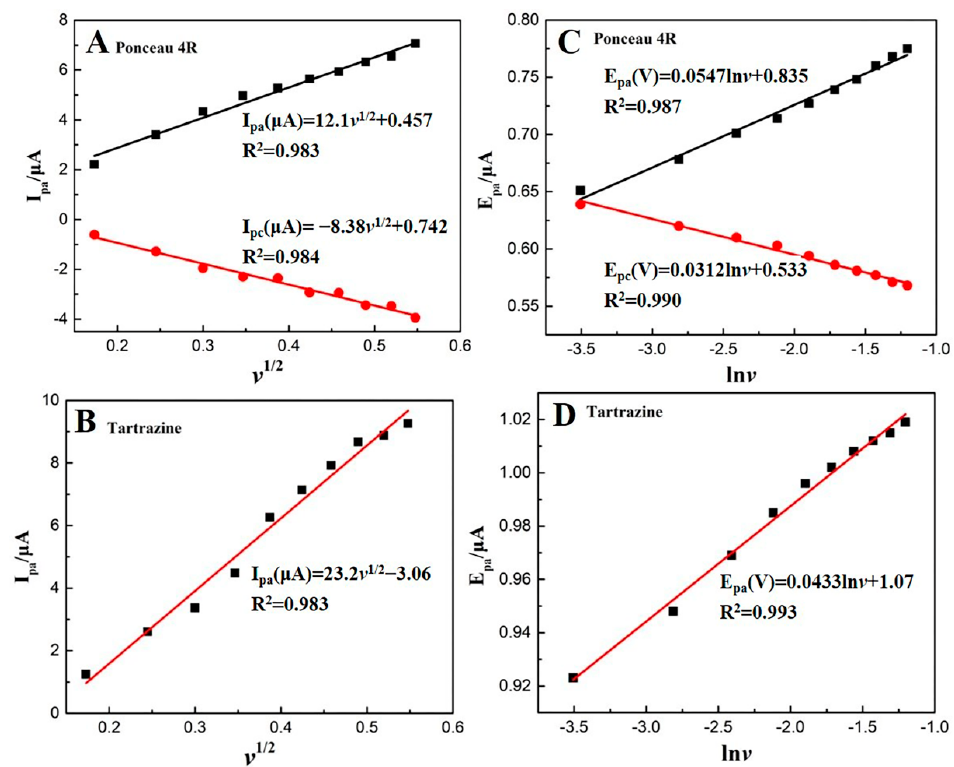
Figure 6. Linear plots of cyclic voltammograms peak currents of ponceau 4R ( A ) and tartrazine ( B ) against the square root of the scan rate ( v 1/2 ) and linear plots of redox peak potentials of ponceau 4R ( C ) and tartrazine ( D ) against the natural logarithm of the scan rate (ln v ).